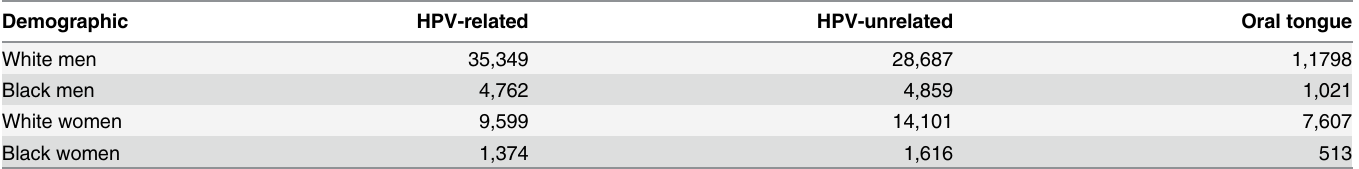
Table 1. Number of cases of oral (oropharyngeal and oral cavity) squamous cell carcinoma among ages 0 – 84 between 1973 – 2012 by race and can- cer subsite group.